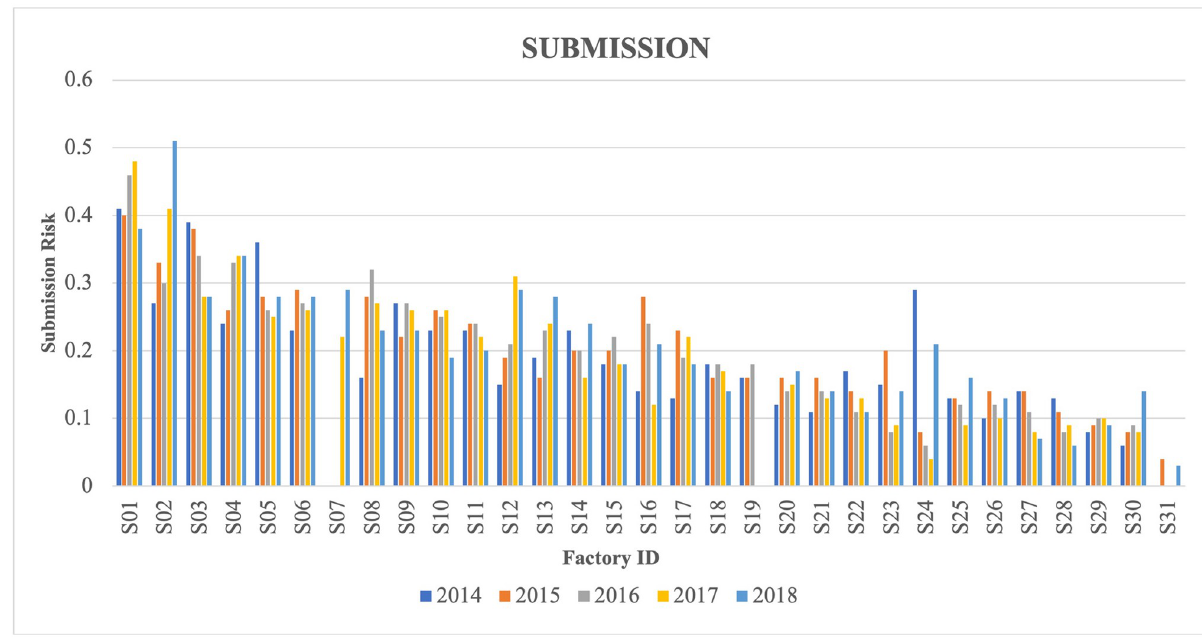
Fig 1. Submission risk (percentage) of lesions for 31 Irish factories per year (2014–2018).